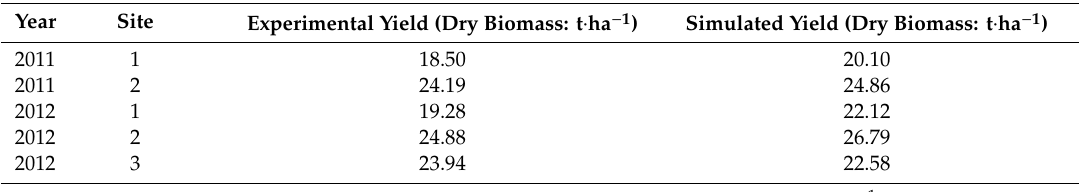
Table 2. Comparison between observed and simulated yields.